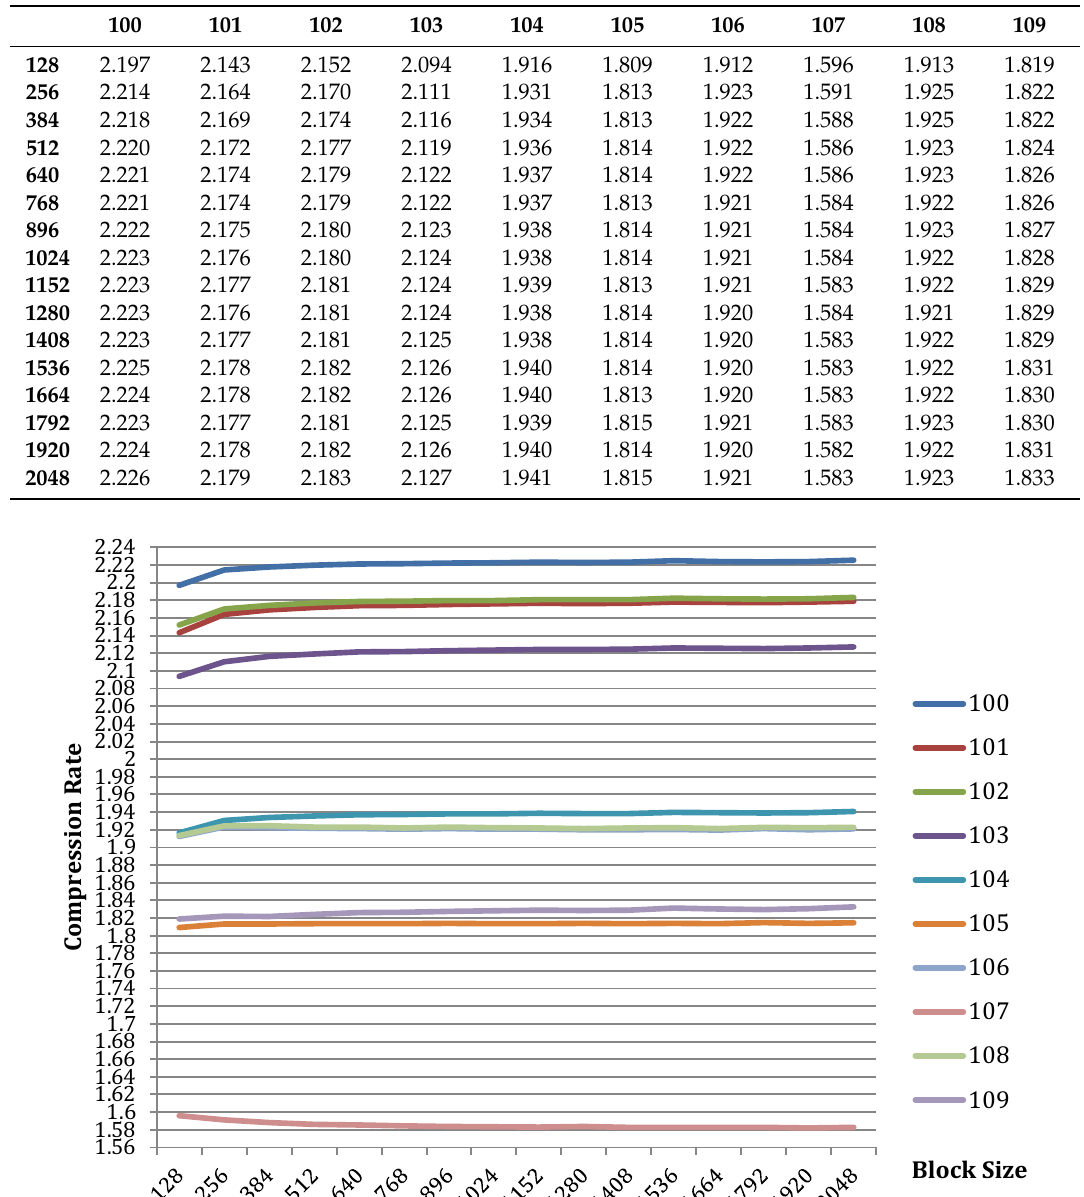
Table 2. Block size and compression rate.